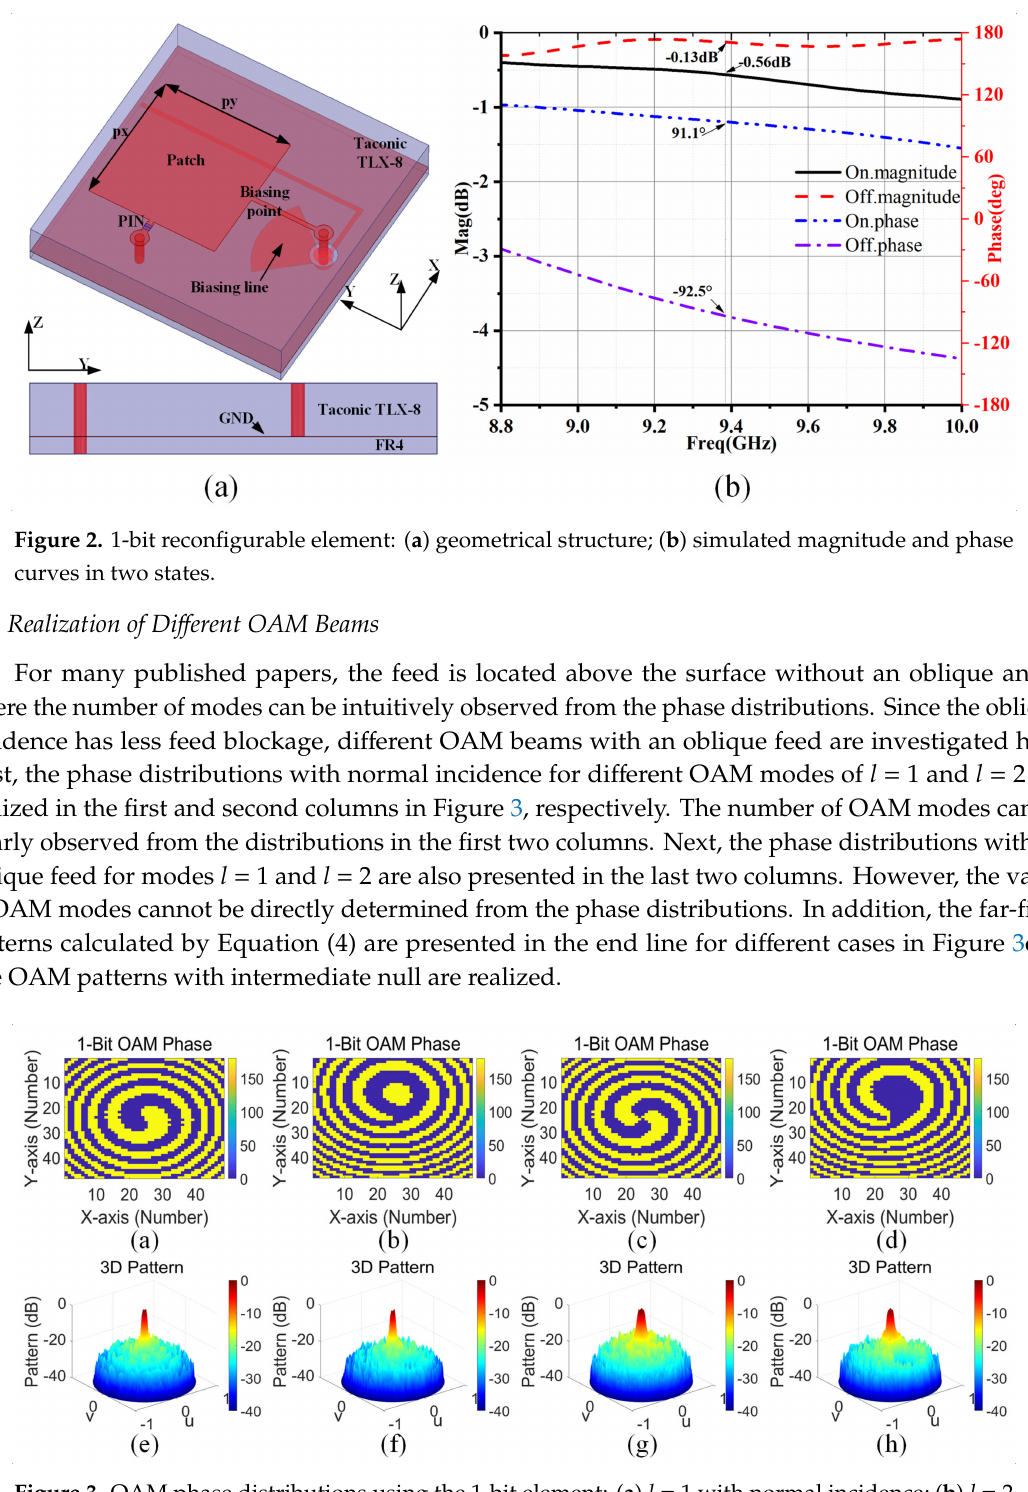
Figure 3. OAM phase distributions using the 1-bit element: ( a ) l = 1 with normal incidence; ( b ) l = 2 with normal incidence; ( c ) l = 1 with oblique incidence; ( d ) l = 2 with oblique incidence. 3D far-field patterns using the 1-bit element: ( e ) l = 1 with normal incidence; ( f ) l = 2 with normal incidence; ( g ) l = 1 with oblique incidence; ( h ) l = 2 with oblique